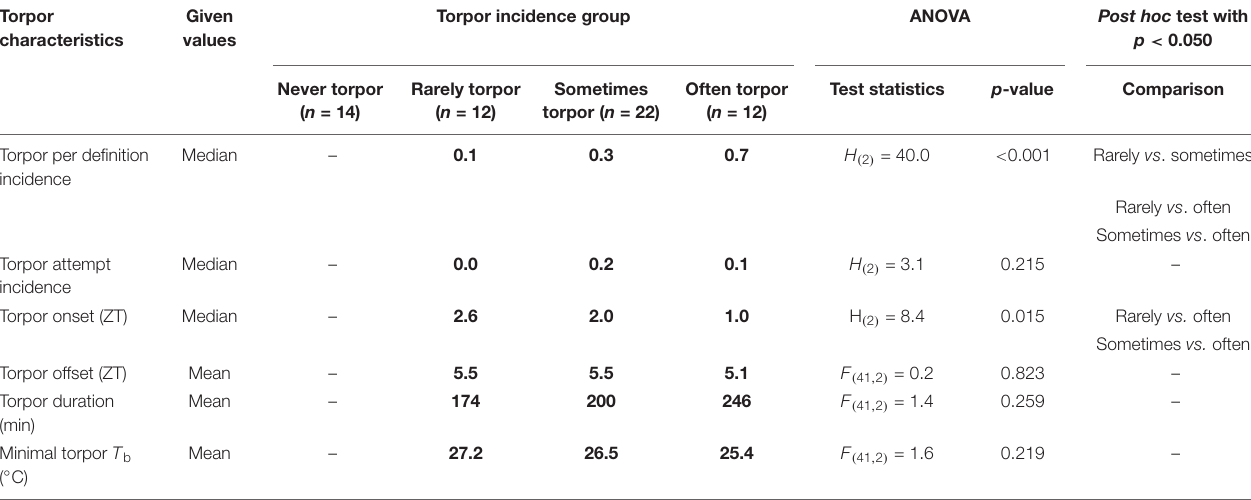
TABLE 1 | Phenotyping of the torpor incidence groups according to the torpor parameters of approach 1.